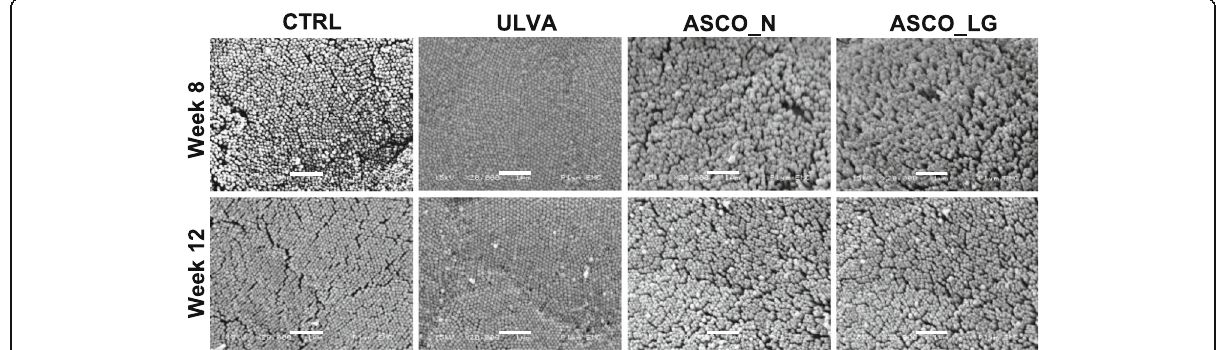
Fig. 1 Scanning electron microscopy images of the hindgut of juvenile Atlantic cod ( Gadus morhua) from each treatment (CTRL, ULVA, ASCO) at Week 8 and Week 12. Scale bar represents 1 μ m